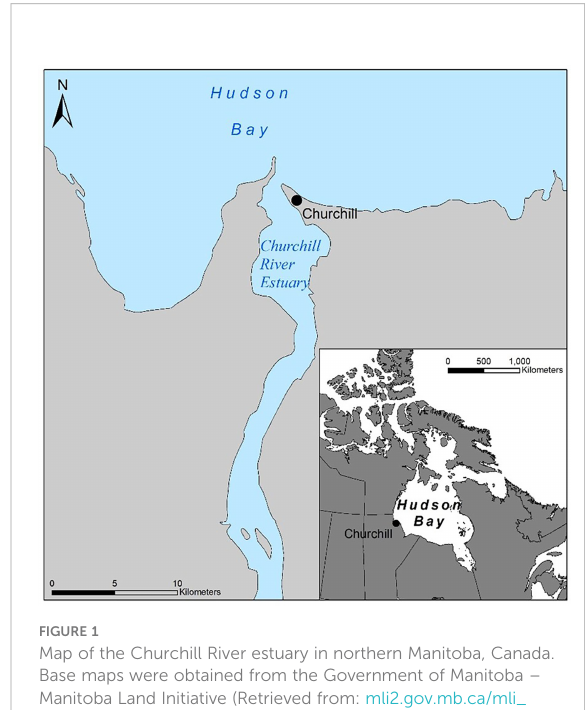
FIGURE 1 Map of the Churchill River estuary in northern Manitoba, Canada. Base maps were obtained from the Government of Manitoba – Manitoba Land Initiative (Retrieved from: mli2.gov.mb.ca/mli_